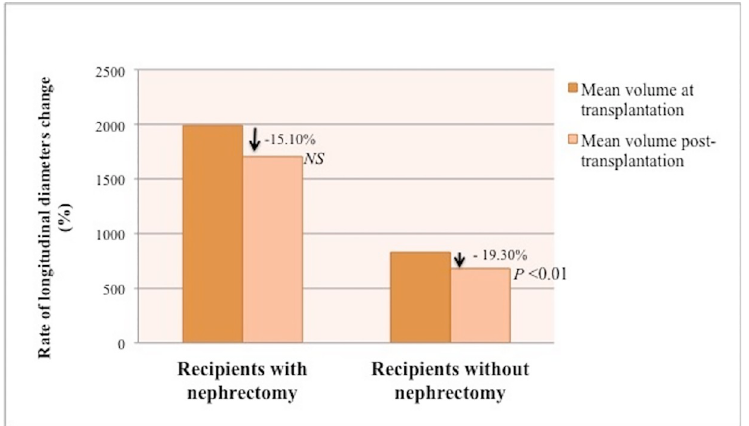
Fig 5. Rate of change in native kidney volume after transplantation in patients with ADPKD. Patients who did not undergo simultaneous nephrectomy displayed a highly significant reduction of kidney volume after transplantation, while patients who underwent simultaneous nephrectomy had a reduction of kidney volume, although not statistically significant.